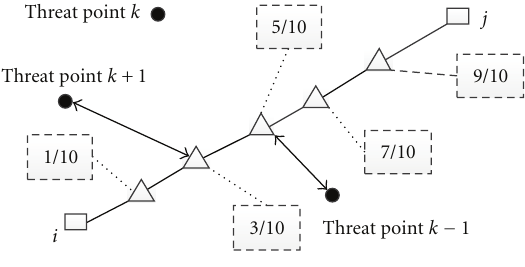
Figure 2: Modeling of the UCAV threat cost